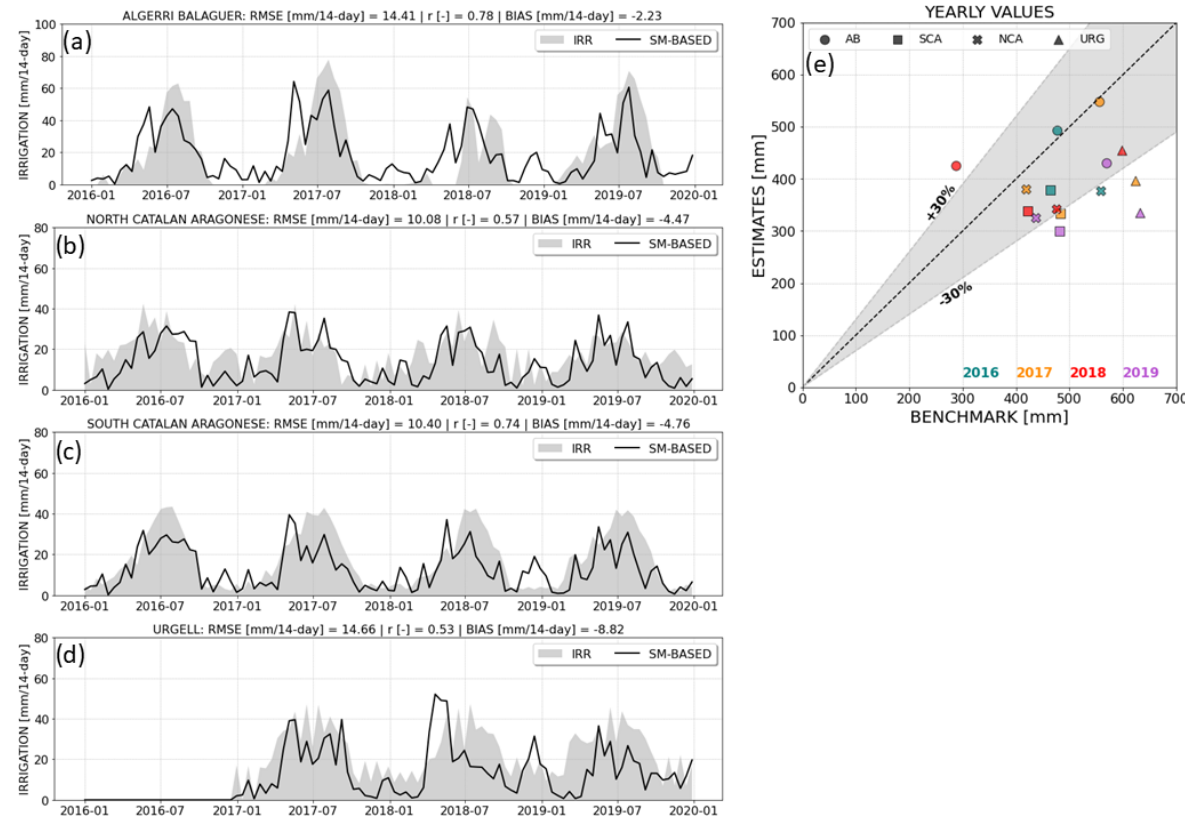
Figure 5. (a–d) The 14d aggregated time series of irrigation estimates (the black lines) over the four considered pilot districts within the Ebro basin against the benchmark rates (the light grey shaded areas). (e) Yearly comparison with data referring to different districts (AB: Algerri Balaguer, SCA: South Catalan Aragonese, NCA: North Catalan Aragonese, URG: Urgell) and years indicated through different markers and colors, respectively. The interval indicating a relative error of ± 30% is shown as well.